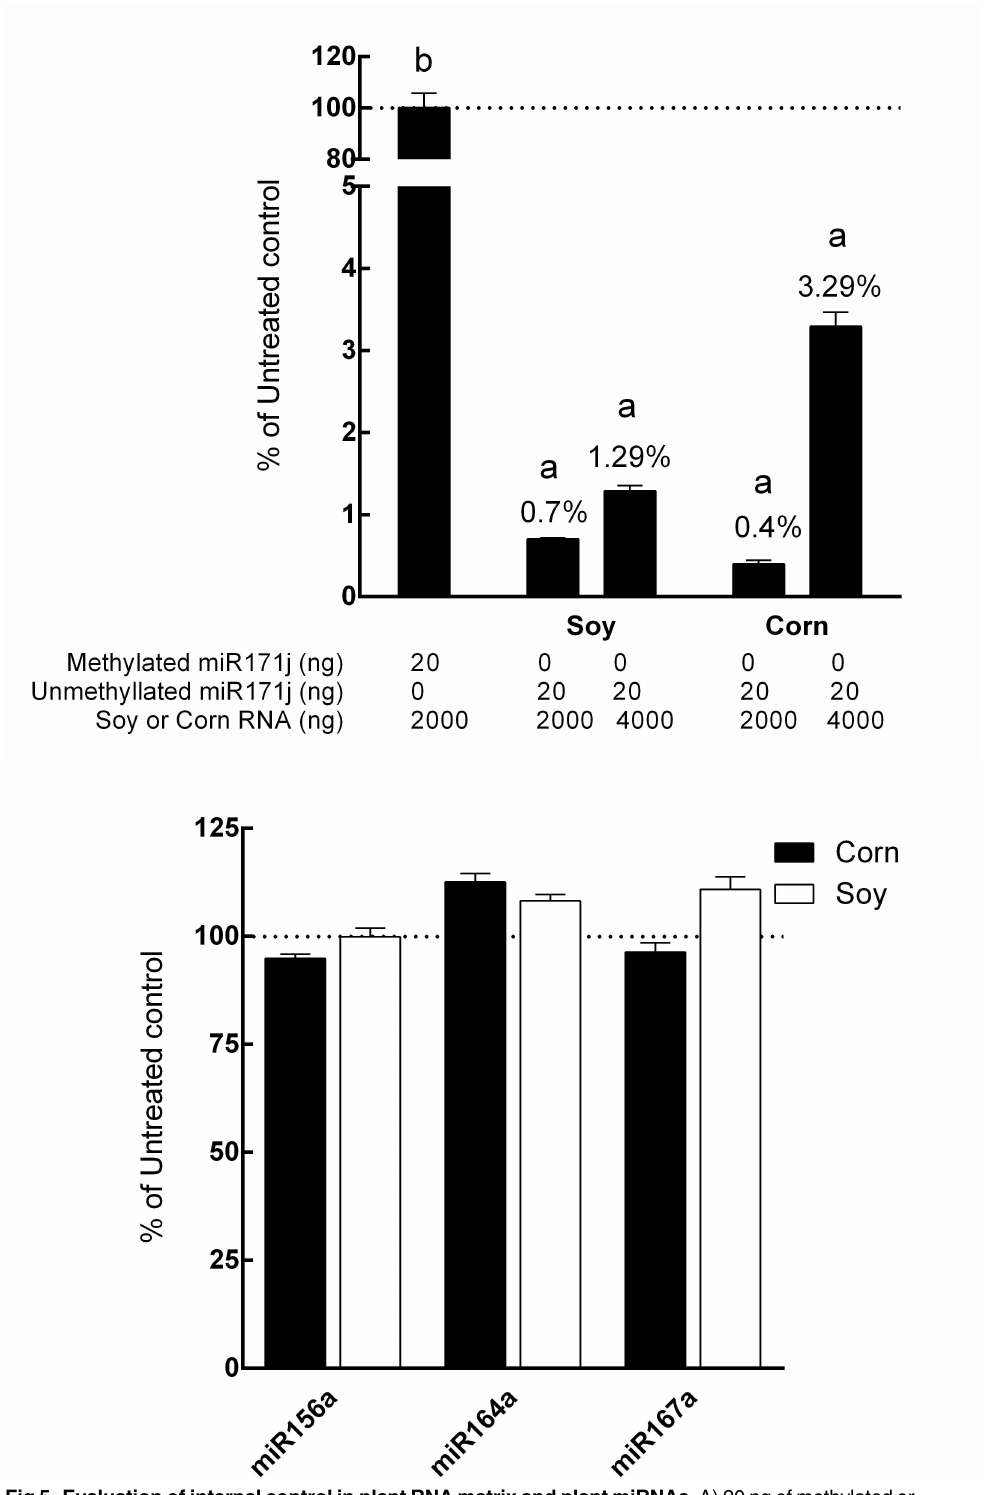
Fig 5. Evaluation of internal control in plant RNA matrix and plant miRNAs. A) 20 ng of methylatedor unmethylated miR171jadded to 2000 or 4000 ng of soy or corn total RNA or B) 2000 ng corn and soy total RNA were treated with or without periodate,followedby β elimination, and analyzedby qRT-PCR as describedin Materialsand Methods. Data is presented as a percentage of miRNAs detected in the treatment group to that of